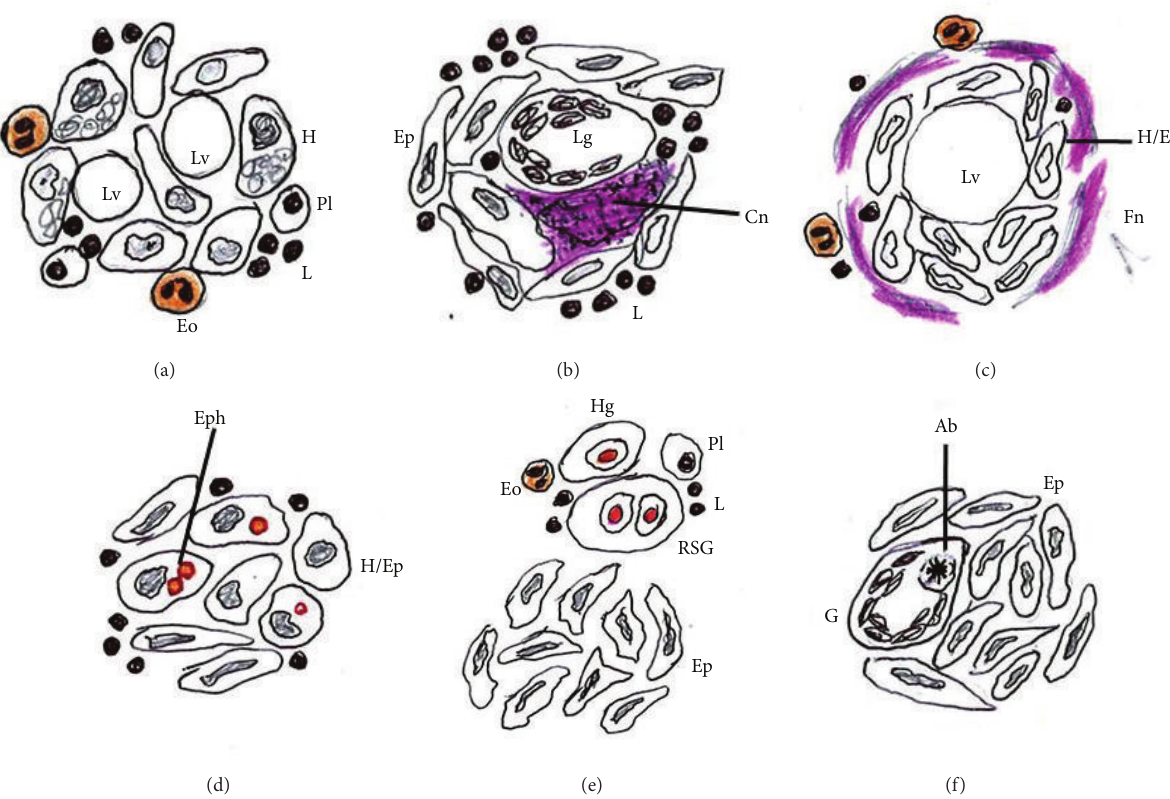
Figure 2: Schematic line representation of various morphological patterns of bone marrow granulomas associated with different etiologies. (a) Lipid granuloma commonly described in the earlier literature, (b) tubercular caseating epithelioid granuloma with Langhans giant cell, (c) fibrin ring/“doughnut” granuloma seen in Q-fever, brucellosis, and sometimes in viral infections, (d) histiocytic/epithelioid granuloma with erythrophagocytosis in typhoid fever, (e) epithelioid granuloma seen in Hodgkin lymphoma and surrounding atypical mononuclear cells and polymorphous inflammatory infiltrate, and (f) naked, noncaseating (sarcoidal type) epithelioid granuloma seen in sarcoidosis. Ab: asteroid body, Cn: caseous necrosis with eosinophilic, granular appearance; Eo: eosinophils; Ep: epithelioid histiocytes with characteristic elongated, slipper shaped nuclei; Eph: erythrophagocytosis; Fn: fibrinoid necrosis/material; G: multinucleated giant cell; H: foamy histiocytes with or without engulfed debris; Hg: mononuclear Hodgkin cell with eosinophilic macro nucleoli; L: lymphocytes; Lv: lipid vacuole; Lg: Langhans giant cell; Pl: plasma cells; RSG: Reed-Sternberg giant cell characterized by mirror image nuclei with eosinophilic macro nucleoli.